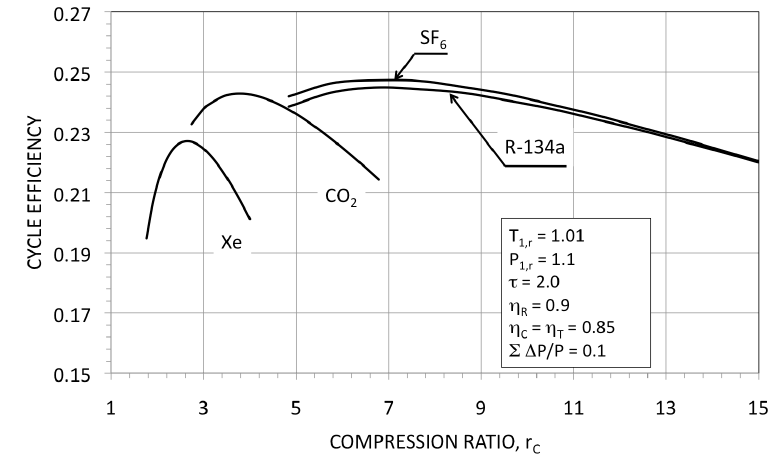
Figure 8. Thermodynamic efficiency for real-gas cycles as a function of the compression ratio for different working